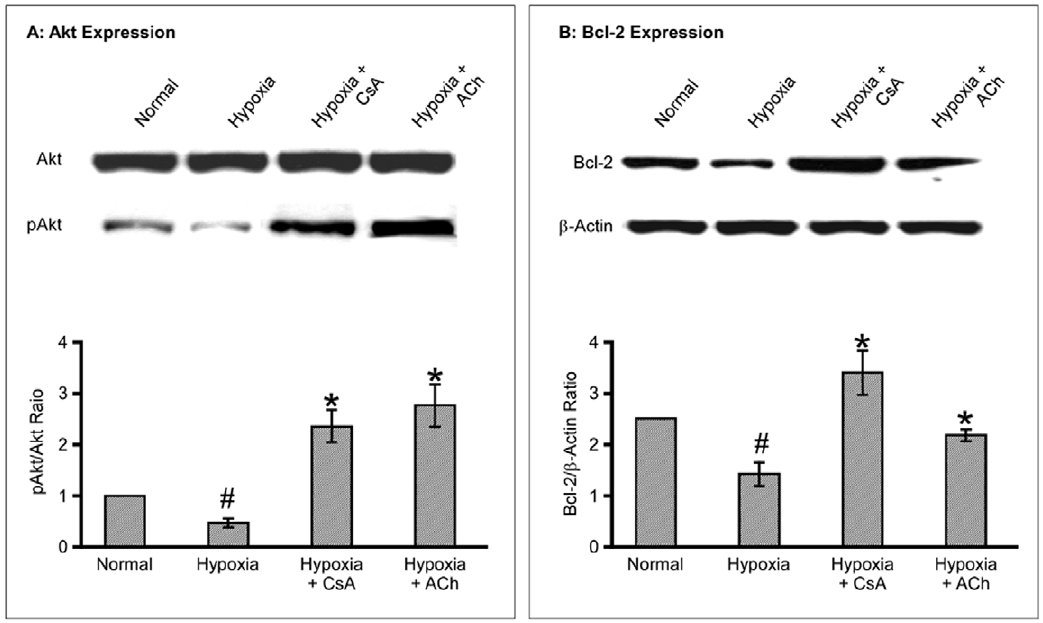
Figure 4. Cell survival Cascade analysis. Representative immunoblot and quantitative analysis of Akt (A) and Bcl-2 (B) in EHTs exposed to hypoxia. Values are mean 6 SD # P , 0.05 versus normal group and * P , 0.05 versus hypoxic group. N=5 in each